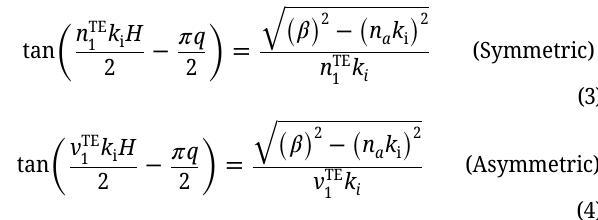
Figure 4 verifies the a-GMR spectral identity. In spectra are given by horizontal crosscuts Figure 4(a), two R 0 of Figure 3(d) and (e) at Λ = 1 μ m. In the plot, at 𝜃 = 2 ◦ , two sharp peaks locate at ① 𝜆 = 1.441 μ m and ② 1.084 μ